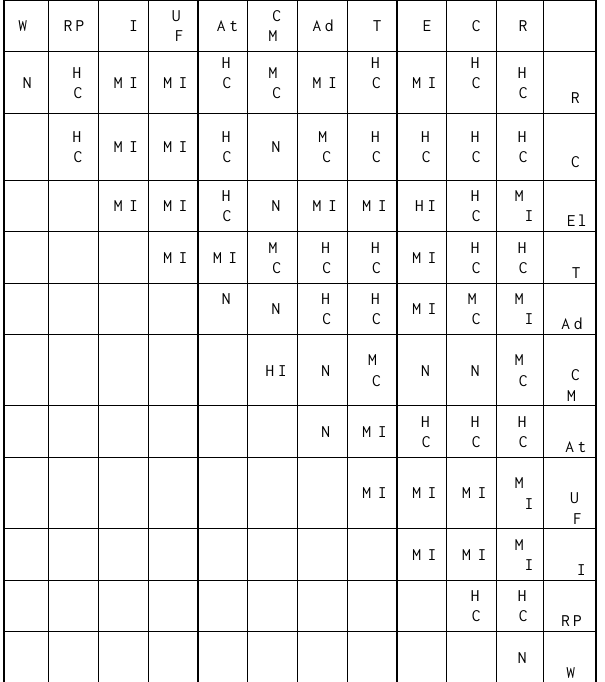
Table 1. Different compatibility levels for different land uses R as Residential, C as Commercial, E as Educational, T as Therapeutic, Ad as Administrative, CM as Cultural and Mosque, A as Athletic, UF as Urban Facilities, I as Industrial, RP as Recreation and Park, W as Wasteland. (Derived from